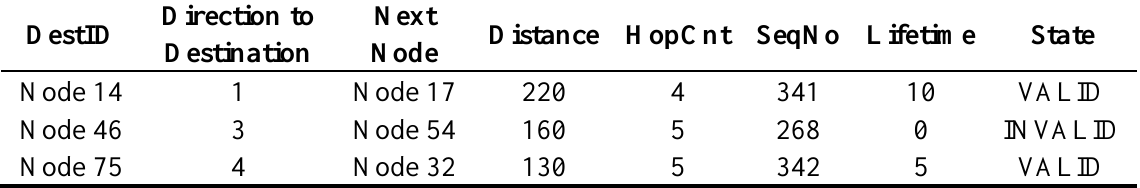
Table 1. Local routing table.